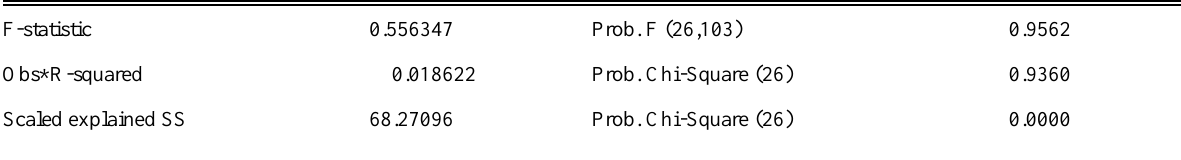
Table 3: Heteroskedasticities